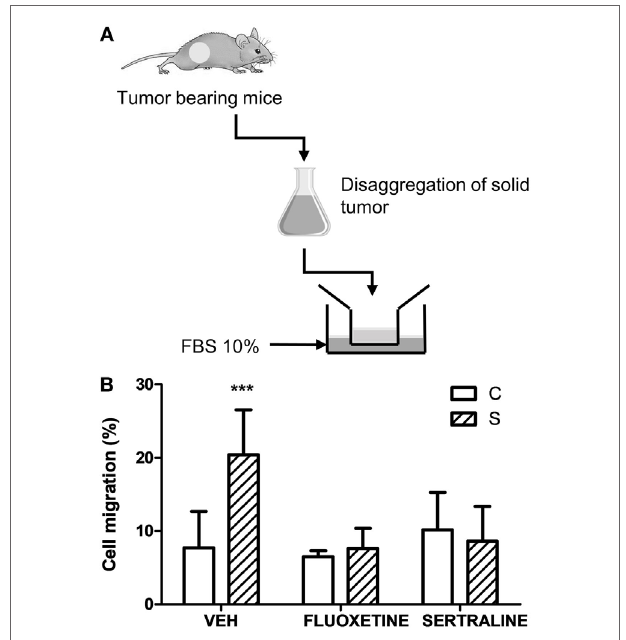
FigUre 6 | Effect of chronic stress and antidepressant treatment on tumor cells migration. (a) Schematic representation of the experimental protocol. 14 days post subcutaneous injection of EL4 cells in mice from different experimental groups, solid tumors were excised and disaggregated. 5 × 10 4 cells were seeded in the upper well of transwell migration chamber and RPMI with 10% FBS as attractant. After 24 h, cells in the upper and in the lower chamber were counted. (B) Cell migration is presented as percentage of total cell count for each sample. Values are expressed as mean ± SEM. n = 5 mice per group. *** p < 0.001 respect to control